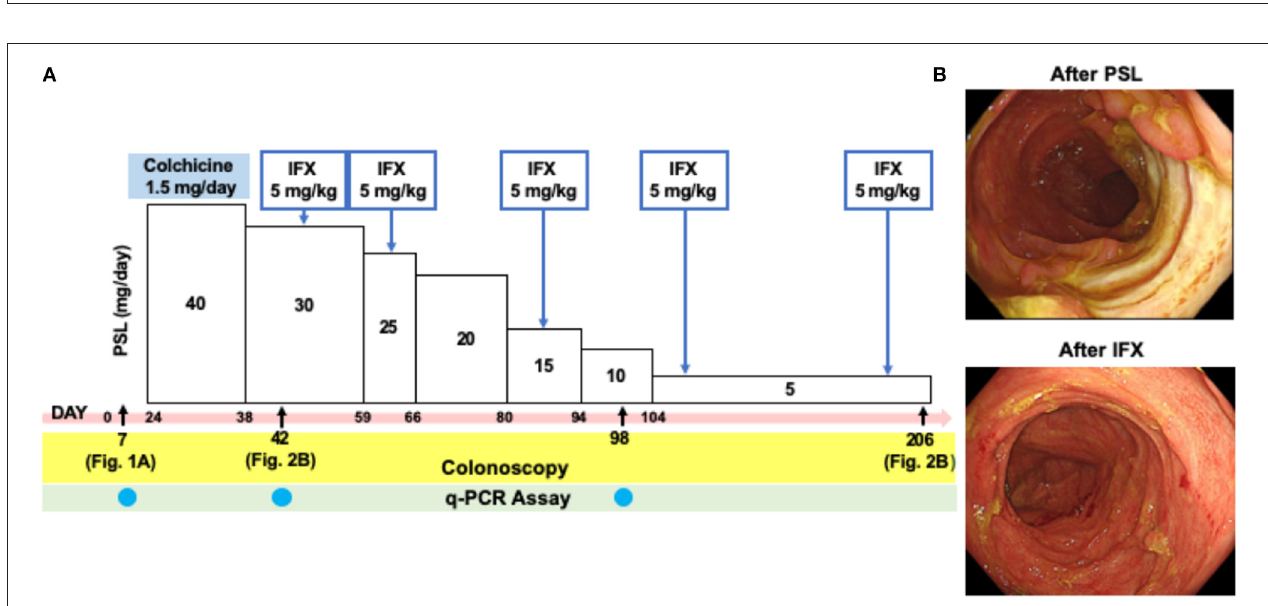
FIGURE 1 | Colonoscopic and pathological findings in a patient with intestinal Behçet’s disease before the treatment. (A) Colonoscopy revealed punched-out, deep and semi-circumferential ulcers in the cecum (top), and sigmoid colon (bottom), respectively. (B) Colonic biopsy samples were subjected to hematoxylin and eosin (H&E) staining and immunohistochemical analysis to visualize CD3 + T cells, CD68 + macrophages, and myeloperoxidase (MPO) + granulocytes. Accumulation of immune cells and destruction of crypt architecture were observed in tissues stained by H&E. Colonic mucosa of this patient with intestinal Behçet’s disease was characterized by the infiltration of CD3 + T cells, CD68 + macrophages, and MPO + granulocytes. Scale bar, 100 µ m.